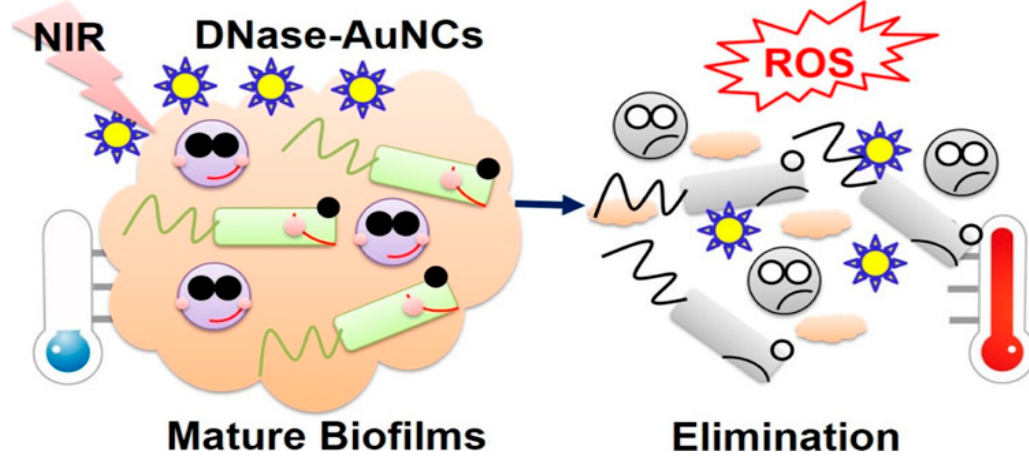
Figure 6. Mechanism of biofilm elimination by gold nanoclusters coated with DNase (DNase-AuNCs) under NIR irradiation. Reproduced from [59], with permission from American Chemical Society, 2020.